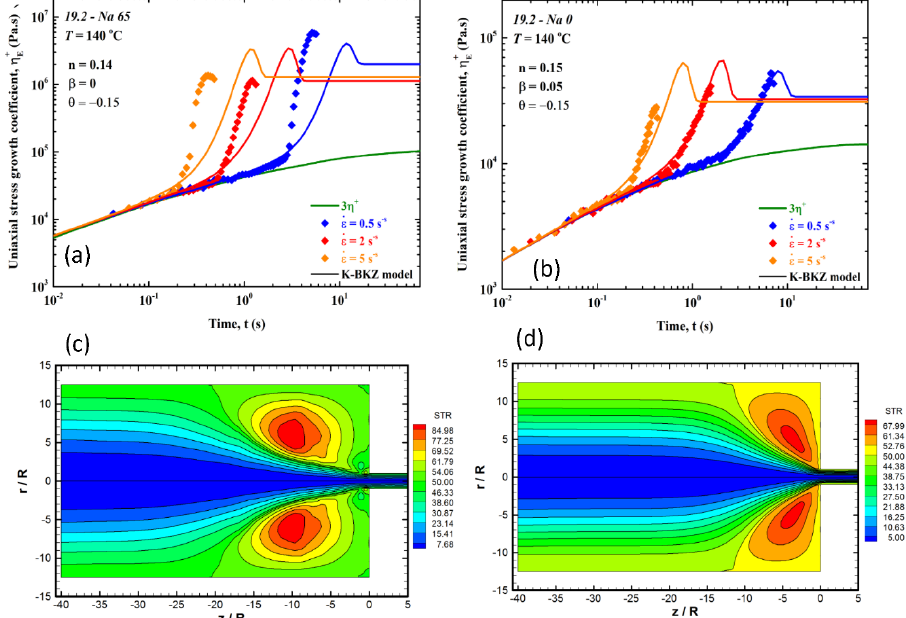
Figure 3. ( a ) The uniaxial tensile stress growth coefficient in start-up of uniaxial extension for sample 19.2-Na 65 at 140 ◦ C; ( b ) the uniaxial tensile stress growth coefficient in start-up of uniaxial extension for sample 19.2-Na 0 at 140 ◦ C. The continuous lines are fits of the K-BKZ/Wagner model to the experimental data. ( c ) Flow patterns (streamlines) for the copolymer 19.2 – Na 65 at 140 o C for a die with L/D =33 at the apparent shear rate of A γ & =400 s -1 . ( d ) Flow patterns (streamlines) for the copolymer 19.2 - Na 0 at 140 o C for a die with L/D =33 at the apparent shear rate of A γ & =400 s -1 . These figures clearly show that a higher extensional viscosity produces a larger and stronger